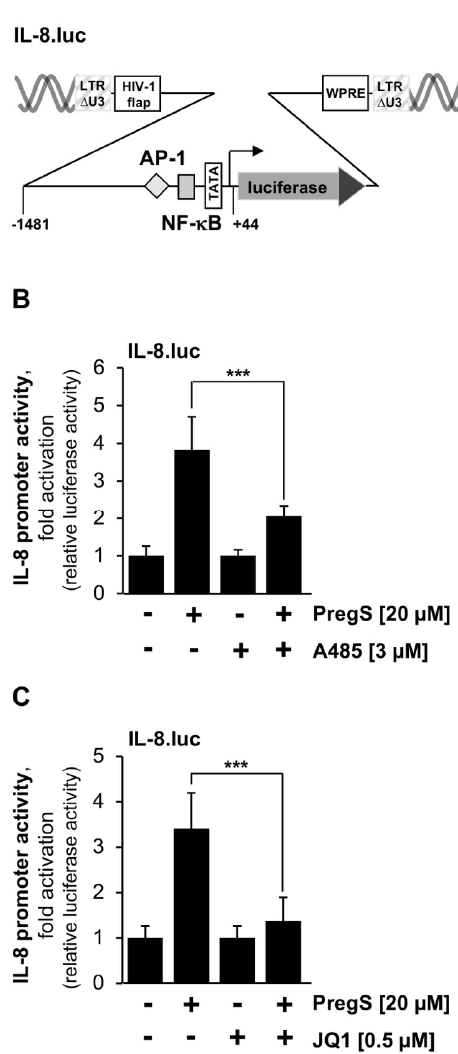
Figure 3. Pharmacological inhibition of CBP/p300 and BET proteins attenuates interleukin-8 pro- moter activity following stimulation of TRPM3 channels. ( A ) Provirus containing the IL-8.luc reporter gene, encompassing IL-8 gene sequences from − 1481 to +44. ( B , C ) T-REx-TRPM3 cells were infected with a recombinant lentivirus containing the IL-8.luc reporter gene. The cells were treated, stimulated, harvested, and analyzed as described in the legend in Figure 2. Data shown are mean +/ − SD of four ( B ) or three ( C ) independent experiments performed in quadruplicate (*** p < 0.001).